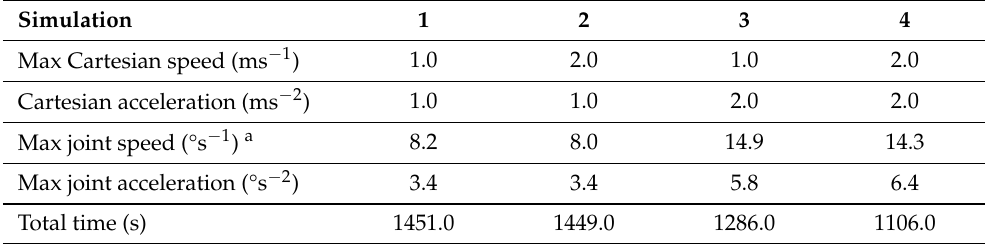
Figure 7. Robot path for servicing one layer of leaves. Table 2. Time studies for different Cartesian accelerations and maximum